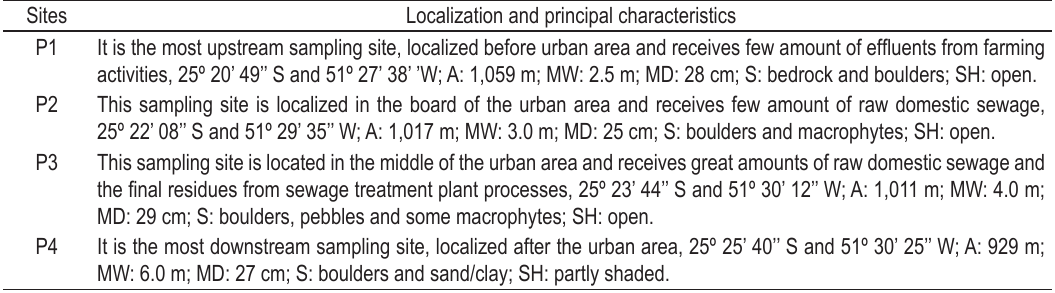
Table 1. Location of sampling sites in the Cascavel Stream, Guarapuava, Paraná State. Sites Localization and principal